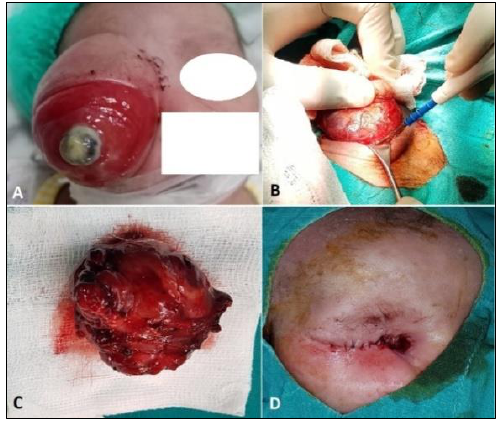
Figure 1: A) Proptosis with severe corneal melting. B) Lid sparing modified exenteration. C) Excised tumor.